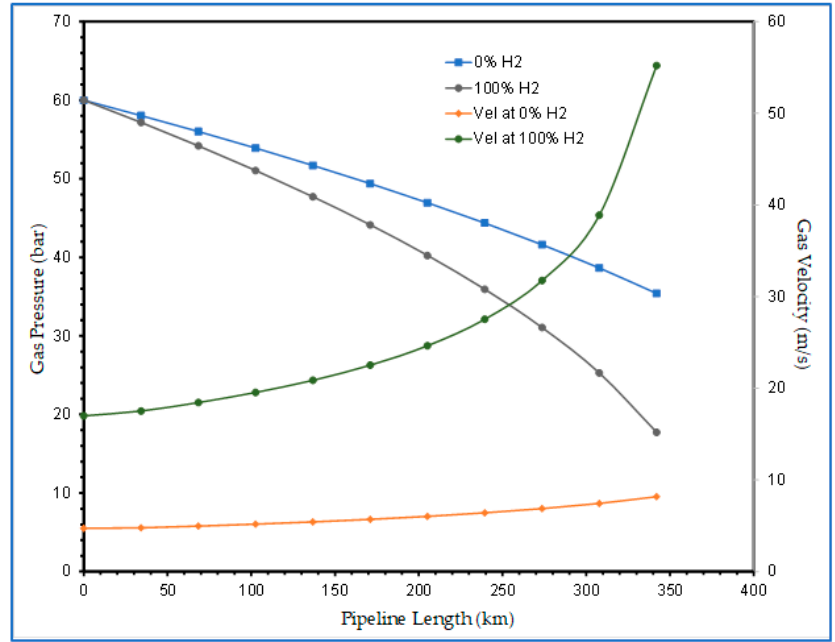
Figure 13. Trade ‐ off of pressure versus velocities in the hydrogen blend pipeline Figure 13. Trade-off of pressure versus velocities in the hydrogen blend The trade ‐ off behaviour between the pressure loss and velocity increase can be man ‐ aged with the use of lower blends of hydrogen in natural gas. 5. Discussion A key parameter in constant energy delivery when natural gas is to be substituted with hydrogen is the volume of hydrogen that will be required to deliver an equivalent amount of energy for a given volume of natural gas. For the parameters examined in this work, 570 MMSCFD of natural gas could be replaced by 1779 MMCSFD of hydrogen to deliver the same amount of energy—6440 MW. In other words, a given volume of natural gas would need to be tripled if the same amount of energy it generates is to be supplied by 100% hydrogen. This is attributable to the lower energy content of hydrogen (12 MJ/m 3 ) compared to the energy content of natural gas (36 MJ/m 3 ). Intermediate blends with 20, 40, 60, and 80% hydrogen proportions were also investigated. In addition to concerns of volumetric requirements, safety is also a major deciding factor that deserves due cognisance in the transition from natural gas to hydrogen. The safety of a gas pipeline is hugely dependent on the flow behaviour of the gas stream, amongst other factors. For instance, the flow behaviour of gases in a constant diameter pipeline is expected to show increased pressure drop with higher pipeline capacity and increase in pipe length due to frictional drag along the walls of the pipeline [66,67]. As a result, density reduction, and consequent increase in gas velocity, is experienced in gas pipelines with increasing pipe length (or distance of travel of the gas) [28]; this is evident in Figure 10. Additionally worthy of note in Figure 10 is the hike in the rate of increase in the velocity profile for the curves signifying 60 and 80% hydrogen contents in the blend. This behaviour is attributable to the gross volumetric increase and the consequent density reduction, which occurs as the proportion of the lighter hydrogen phase exceeds that of natural gas in the blend. The extent to which this phenomenon can cause flow parameters (like the gas velocity) to deviate from the safe limits specified by international standards